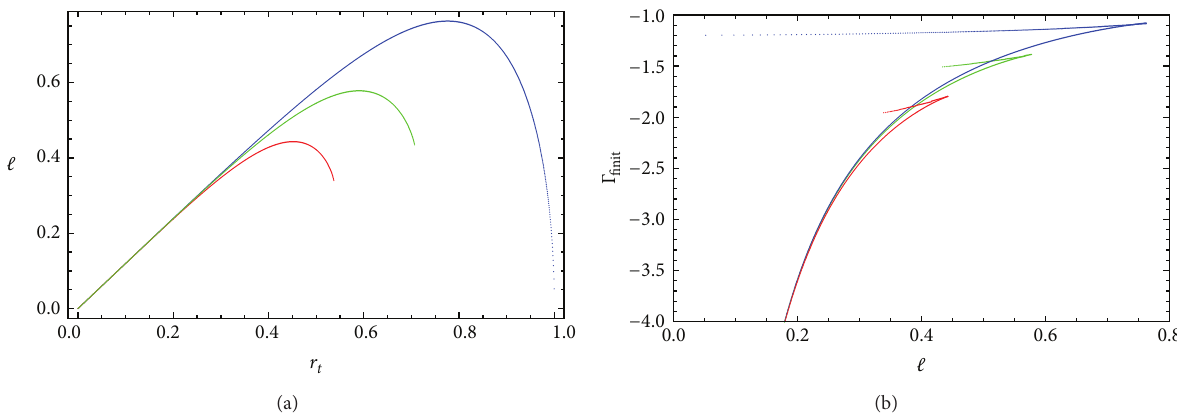
Figure 3: ℓ and Γ as functions of 𝑟 𝑡 and ℓ for 𝑄 = 0.5, 1, √3 which are shown by blue, green, and red, respectively. Note that 𝑄 = 0.5 corresponds to the case of 𝑟 𝐻 = 𝑟 𝜙 and we have plotted it just for a comparison. Here, we have set 𝑟 𝐻 = 1 and 𝜏𝐿 𝑑−2 𝑅 𝑑 /𝐺 𝑑+2 = 1 .